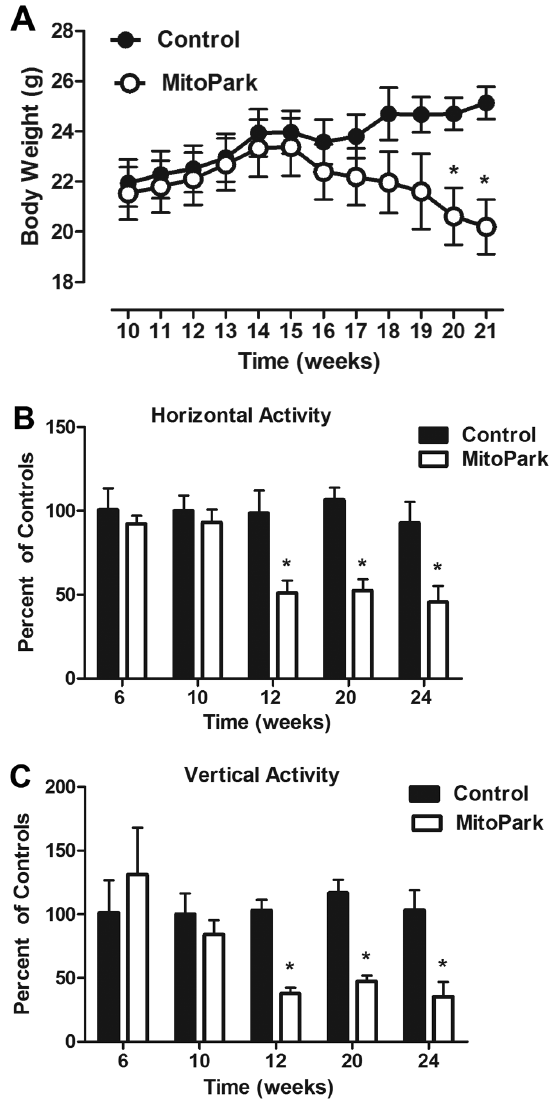
Figure 1. Progressive loss of body weight and motor function in MitoPark mice. (A) Body weights were recorded weekly in either MitoPark mice or their wild-type phenotype littermate controls. (B) Horizontal and (C) vertical locomotor activity were measured at the indicated times in both MitoPark mice or their wild-type phenotype littermate control mice. Data represent mean 6 SEM, (n=10 mice/ group). Significant post hoc effect indicated (*p , 0.05) for MitoPark versus same time point littermate controls.